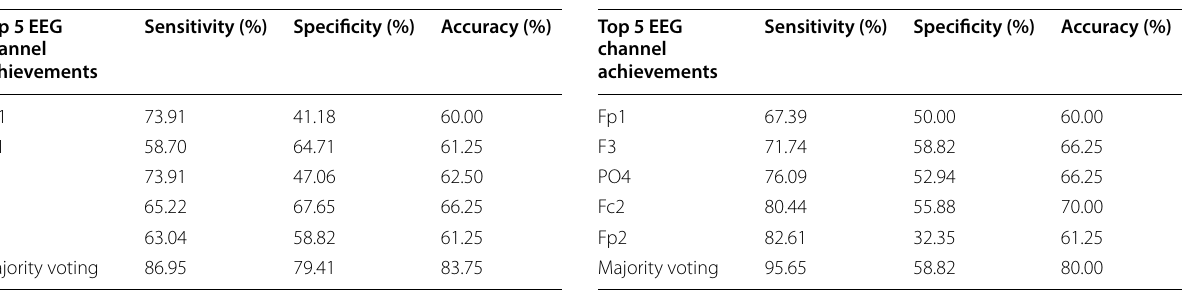
Table 4 Top 5 EEG channel achievements on theta rhythm